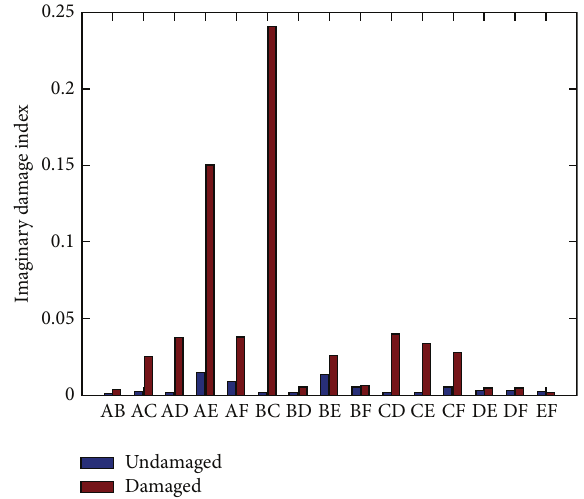
Figure 6: Damage index values using FRFs.